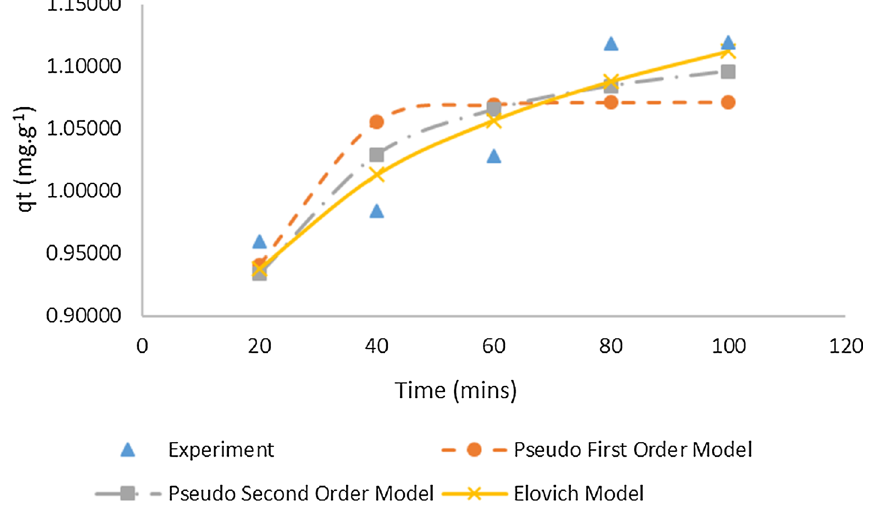
nonlinear kinetic model time profiles for cyanide adsorption onto activated periwinkle shell carbon (APSC) at 80 mg.L